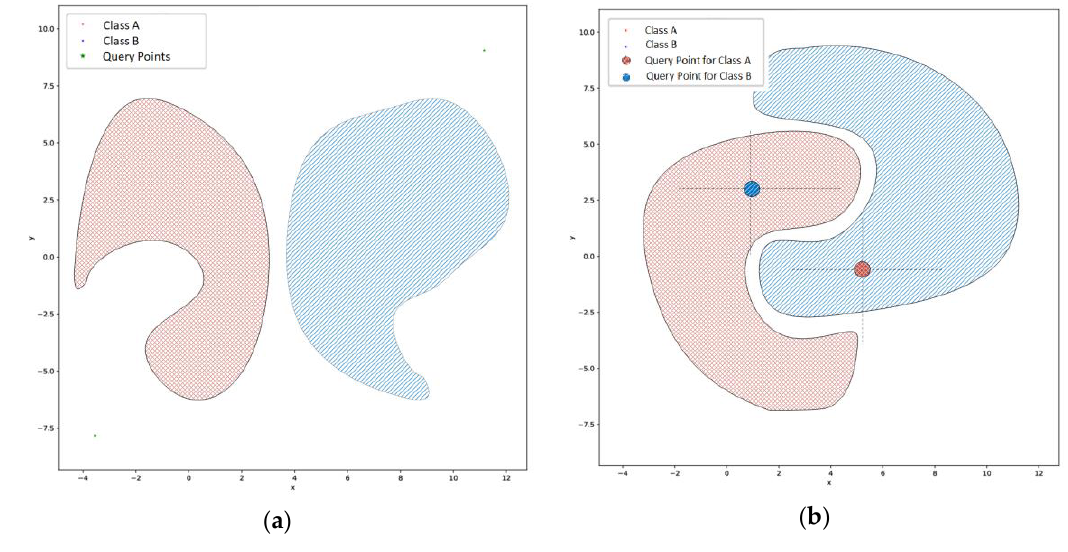
Figure 5. ( a ) Convex dataset; ( b ) banana dataset.